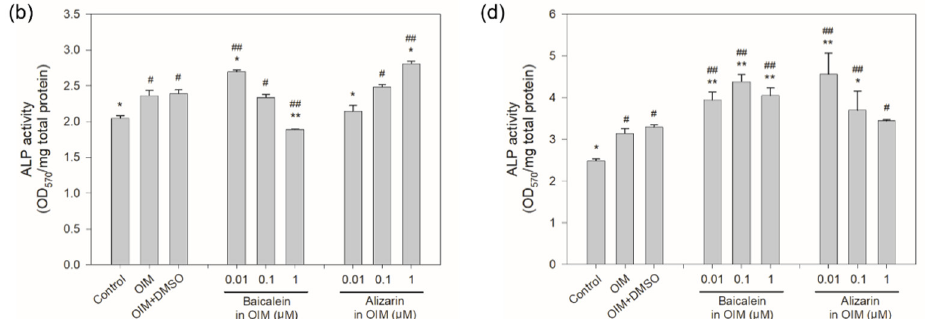
Figure 8. Effect of baicalein and alizarin on the ALP activity of IDG-SW3 and hFOB1.19 cells. ( a , c ) Mouse IDG-SW3 and human hFOB1.19 cells were treated with OIM in the presence of various concentrations of baicalein or alizarin for 14 days, followed by cell staining with Pierce 1-Step NBT/BCIP Solution (Thermo Fisher Scientific, Waltham, MA, USA) according to the manufacturer’s instructions. ( b , d ) The level of alkaline phosphatase activity was quantitated by solubilizing the cells in DMSO and determining the optical density at 570 nm, which was then normalized to total protein (mg). Error bars represent standard deviations ( n ≥ 3). # p < 0.05 and ## p < 0.01, compared to the control; * p < 0.05 and ** p < 0.01, compared to the OIM